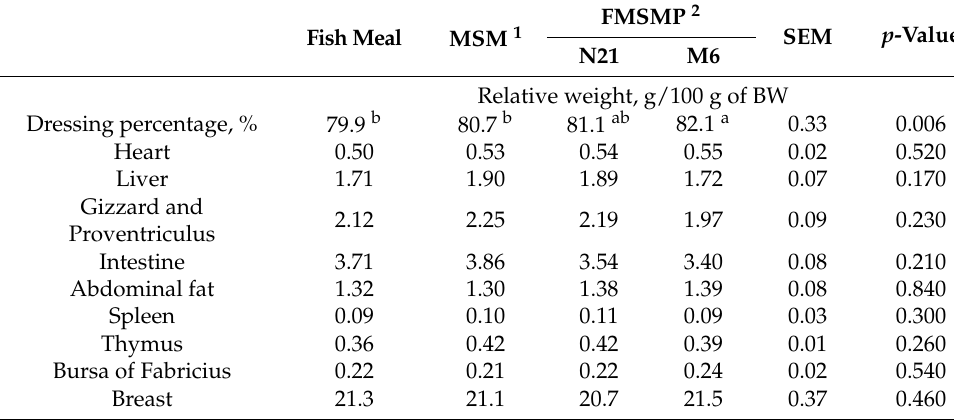
Table 9. Effect of different FMSMPs on organ and tissue weight in